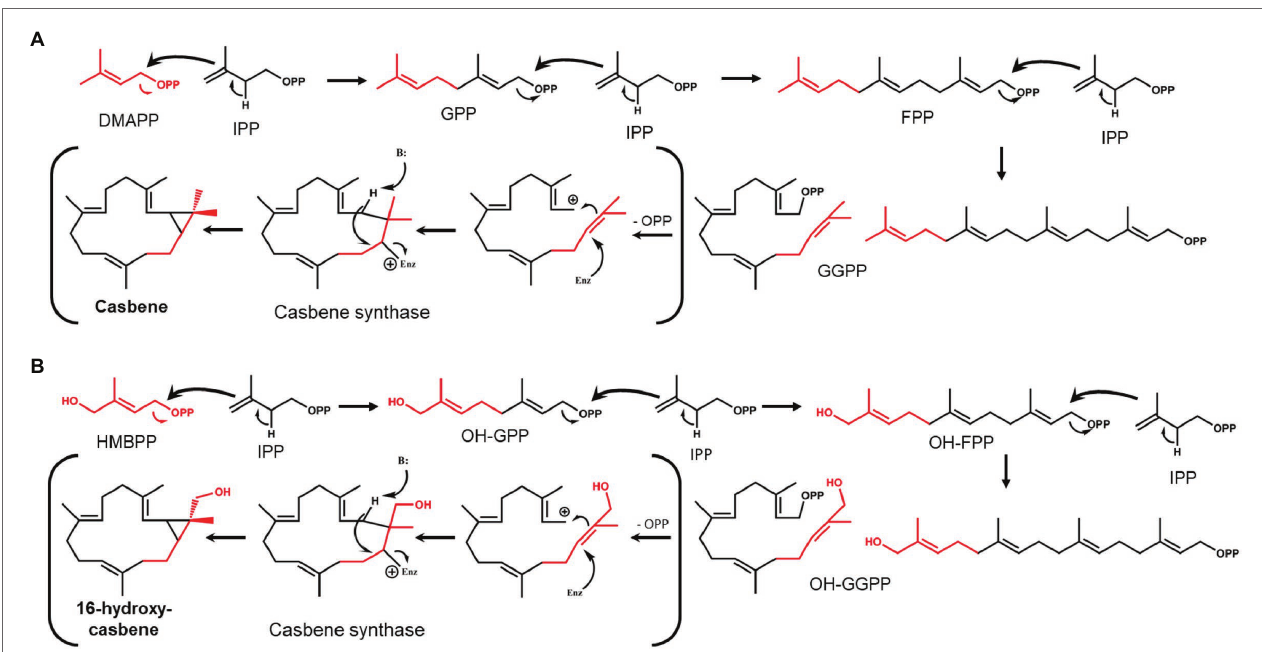
FIGURE 2 | Theoretical formation of GGPP/casbene and OH-GGPP/16-OH-casbene. (A) Condensation of dimethylallyl pyrophosphate (DMAPP) and isopentyl pyrophosphate (IPP) to form GGPP and cyclisation by casbene synthase to form casbene. (B) Condensation of HMBPP and IPP to form OH-GGPP and cyclisation by casbene synthase to form